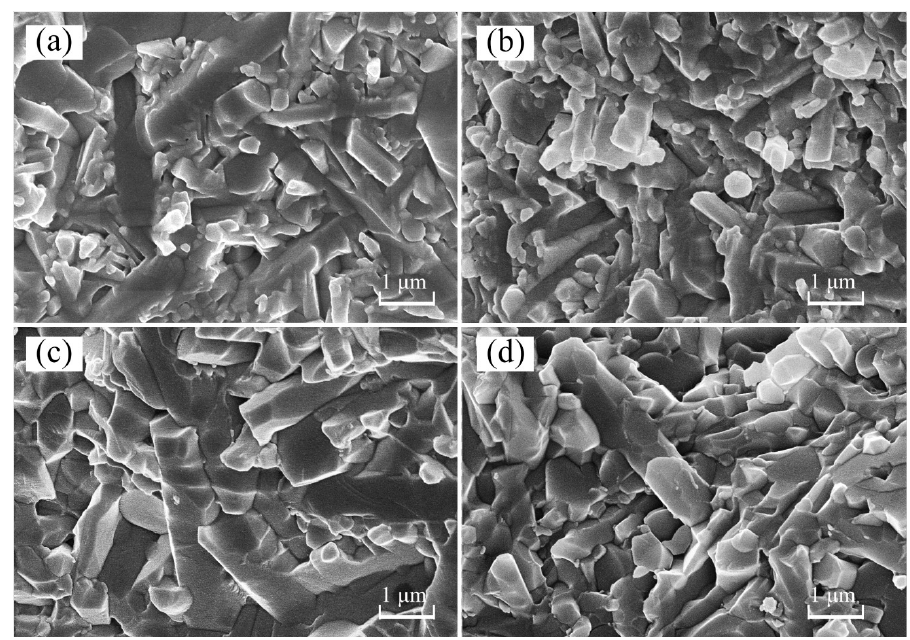
Figure 3. SEM micrographs of the fractured surfaces of Si 3 N 4 samples: ( a ) SYA; ( b ) SCA; ( c ) GYA; ( d ) GCA.